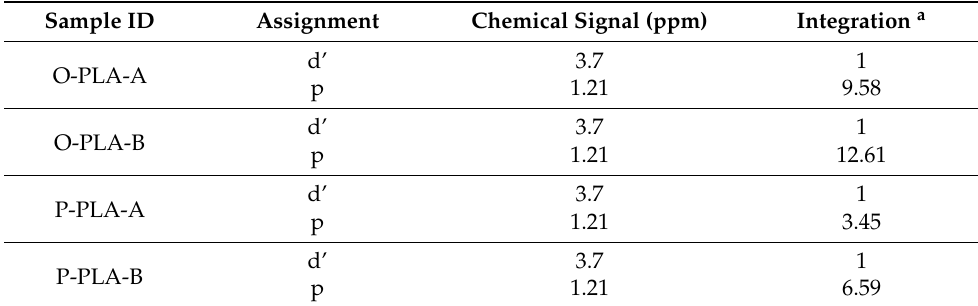
Figure 2. ( a ) Reaction scheme for PLA modification with N-octyltriethoxysilane and ( b ) 1 H NMR of neat and functionalized PLA with different concentrations of N-octyltriethoxysilane: O-PLA-A (1.5 wt%) and O-PLA-B (3.0 wt%). Table 4. Chemical shifts and integration signal